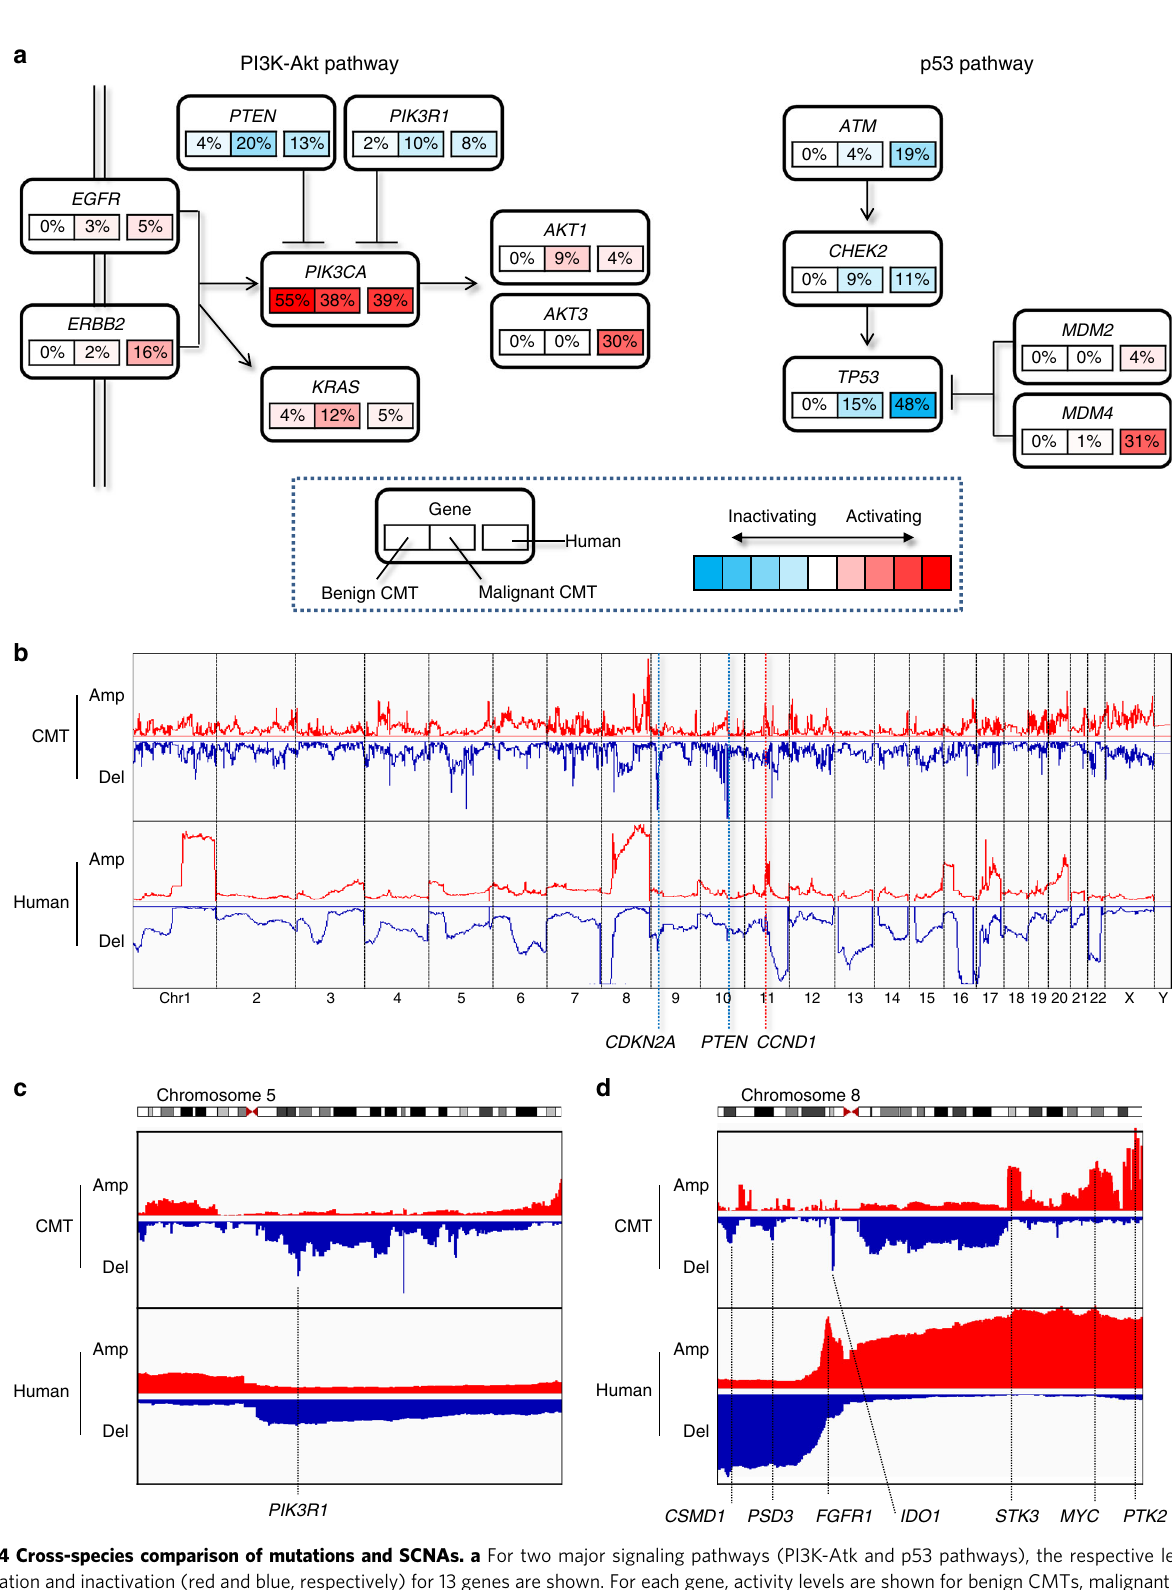
Fig. 4 Cross-species comparison of mutations and SCNAs. a For two major signaling pathways (PI3K-Atk and p53 pathways), the respective levels of activation and inactivation (red and blue, respectively) for 13 genes are shown. For each gene, activity levels are shown for benign CMTs, malignant CMTs, and human breast cancers, respectively. b CMT SCNAs are aligned onto the human reference genome (hg19) and compared with SCNA pro fi les of human breast cancers in the linear space of hg19 (chr1 to chr22 with sex chromosomes). The degrees of ampli fi cation and deletion are presented as the sum of log-ratios in hg19-aligned CMT and human breast cancer cohorts. c Chromosome 5 is shown, where human breast cancer shows arm-level 5p gains and 5q losses. The hg19-aligned CMT genomes show a deletion peak harboring PIK3R1. d Chromosome 8 shows peaks in six genes of hg19-aligned CMT SCNAs (CSMD, PSD3, IDO1, STK3, MYC, and PTK2), along with FGFR1 in an ampli fi cation peak of human breast cancer